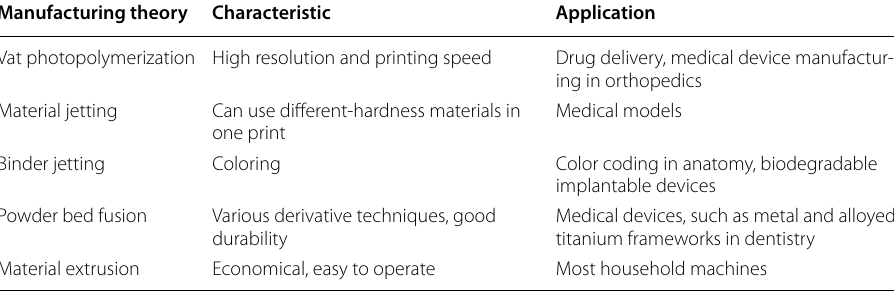
Table 5 Various categories in 3D printing